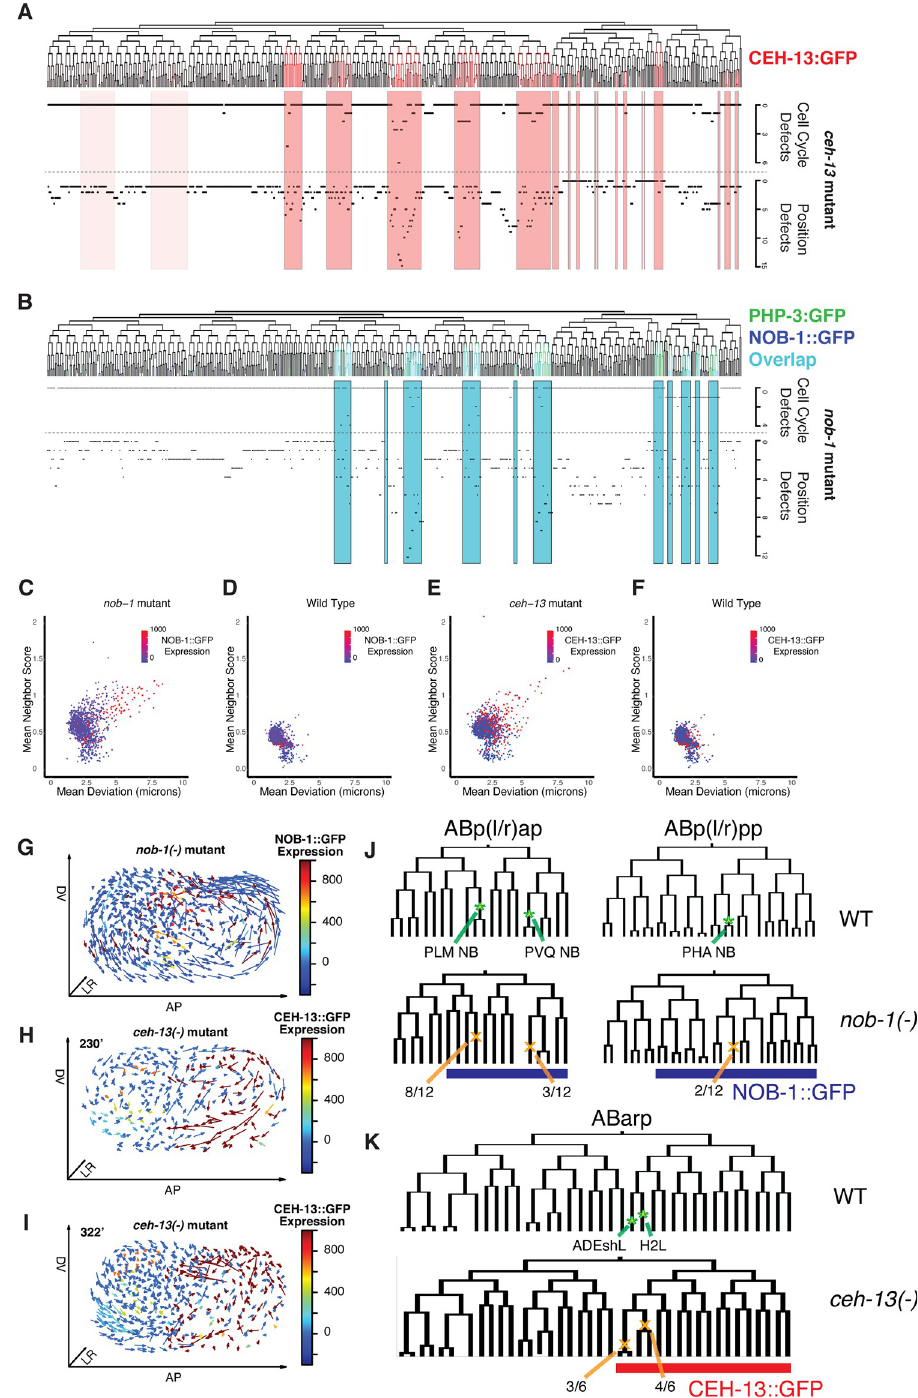
Fig 6. Cell defects are observed in the posterior of both ceh-13 and nob-1 mutant embryos. A) Lineage showing CEH-13::GFP expression with plots of frequency of cell cycle defects and cell position defects for each cell plotted below. Cells expressing CEH-13::GFP during their development are highlighted in pink (ABalap and ABalpp, which express very low levels of CEH-13::GFP, are denoted with lighter shading). Cell cycle defects are defined as missed, ectopic or significant change in division timing of at least 5 minutes and cell position defects are defined as significant deviation of at least 5 μ m from the positions expected from wild-type (see methods). Defects are listed cumulatively for terminal cells, so defects in both a parent and daughter cell would be scored as two defects. B) Lineage showing